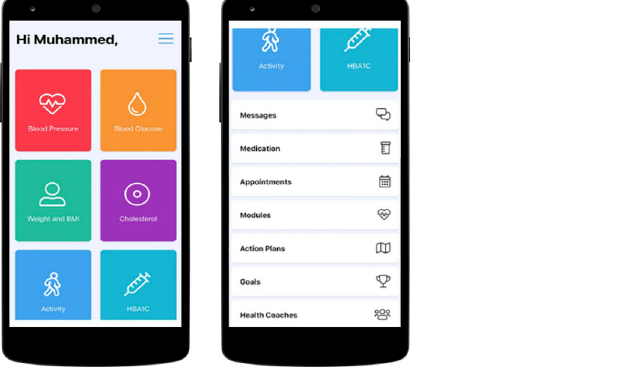
Fig 1. Screenshots of